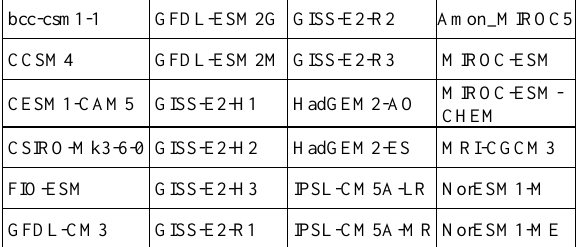
Table 6. List of 24 common models the four RCP scenarios.